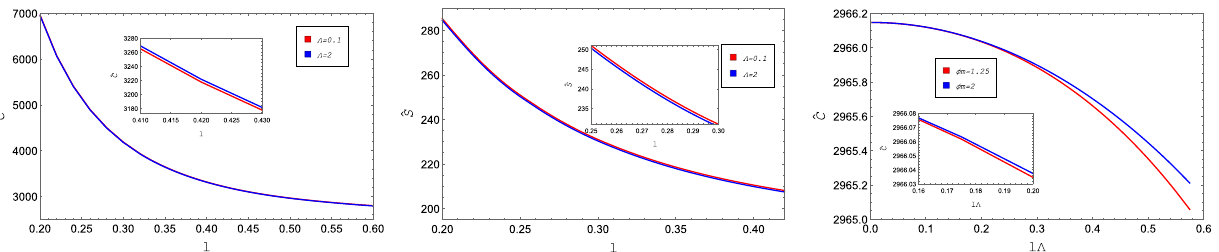
Fig. 1 Left:Therelativesubregioncomplexity ˆ C asafunctionoflength of subregion l for different (cid:3) = 0 . 1 (red) and (cid:3) = 2 (blue). We have fixed φ M = 2. Middle: The relative entanglement entropy ˆ S as a func- tion of length of subregion l for different (cid:3) = 0 . 1 (red) and (cid:3) = 2